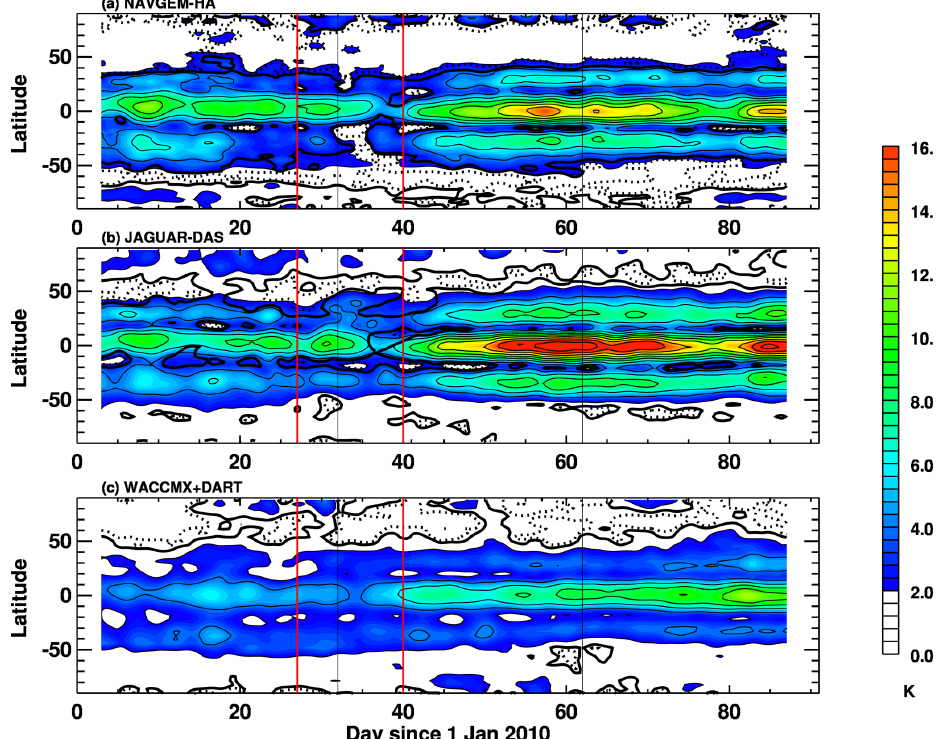
Figure 18. Latitude–time sections of the amplitude in migrating diurnal wave 1 (DW1) temperature variations at 90km altitude from (a) NAVGEM-HA, (b) JAGUAR-DAS, and (c) WACCMX + DART for January–February–March 2010. Thin, solid black contours are drawn every 2K. Bold dashed and solid black contours indicate regions where results from wavelet analysis exceed 90% and 95% confidence levels. Vertical red lines in each panel denote 27 January and 9 February, as described in the text. Vertical black lines in each panel denote 1 February and 1